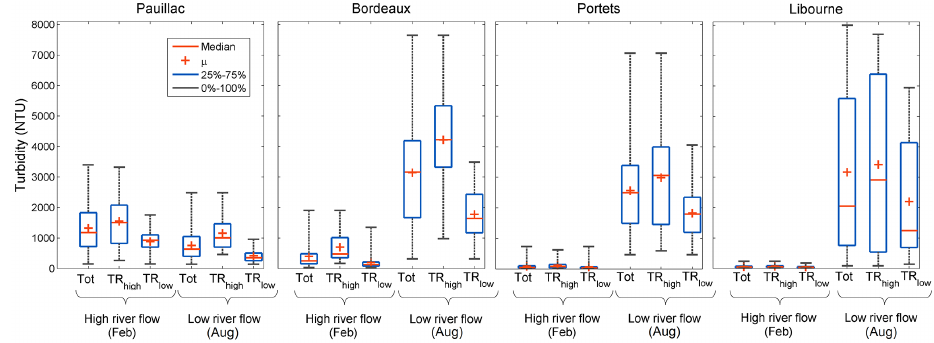
Figure 5. Mean (red cross), median (red bars), percentiles 25–75 (blue bars) and minimum–maximum (black bars) values of tidally averaged turbidity depending on the season (months of February and August) and the tidal range (TR) in each MAGEST station. The minimal, mean and maximal values of river flow in February (2005–2014) are 176, 566 and 2994m 3 s − 1 respectively. These values in August are 56, 103 and 317m 3 s − 1 respectively. High and low tidal ranges correspond to values above the 75th percentile and below the 25th percentile, respectively, of the entire TR data set of each